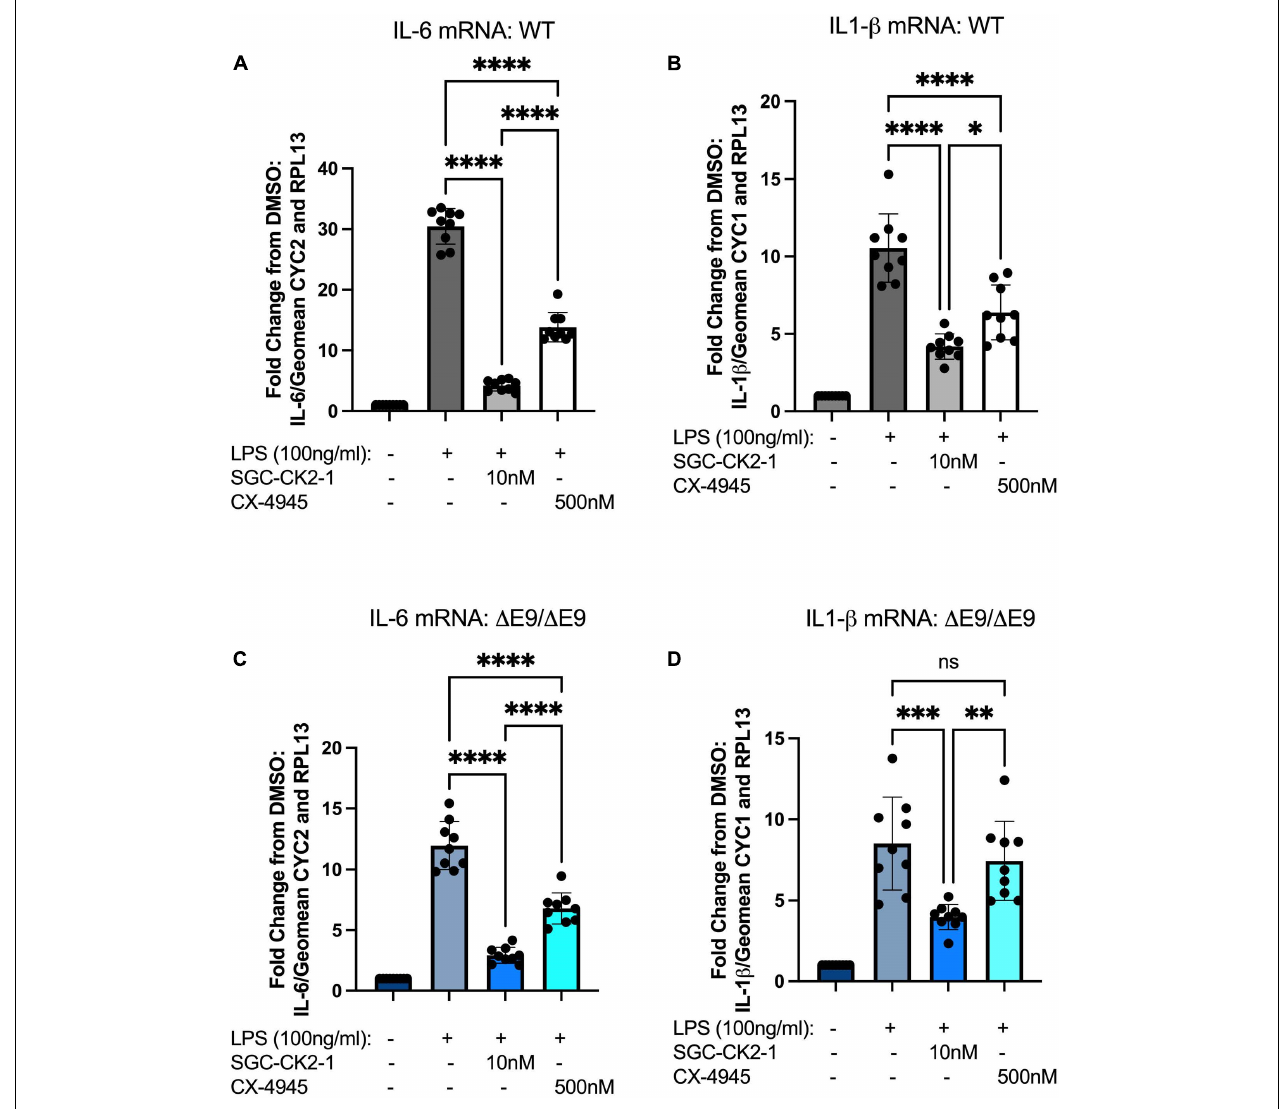
FIGURE 5 | SGC-CK2-1 is more effective at inhibiting mRNA expression of IL-6 and IL1- β in hiPSC-MGLs after LPS stimulation than CX-4945. WT (A,B) and FAD (C,D) MGLs were stimulated with LPS and simultaneously treated with either SGC-CK2-1 or CX-4945 for 24 h. In all conditions, SGC-CK2-1 was more effective at inhibiting both IL-6 and IL1- β mRNA than CX-4945. These data represent three independent differentiations. ∗∗∗∗ p ≤ 0.0001; ∗∗∗ p = 0.0006; ∗∗ p = 0.0077; ∗ p = 0.0293; ns, not significant by one-way ANOVA analysis. Error bars indicate the mean ±